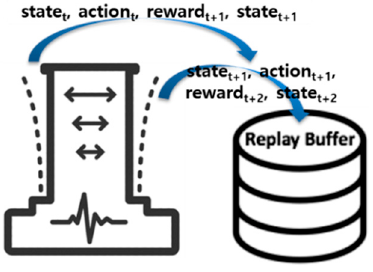
Figure 3. Experience replay of DQN.